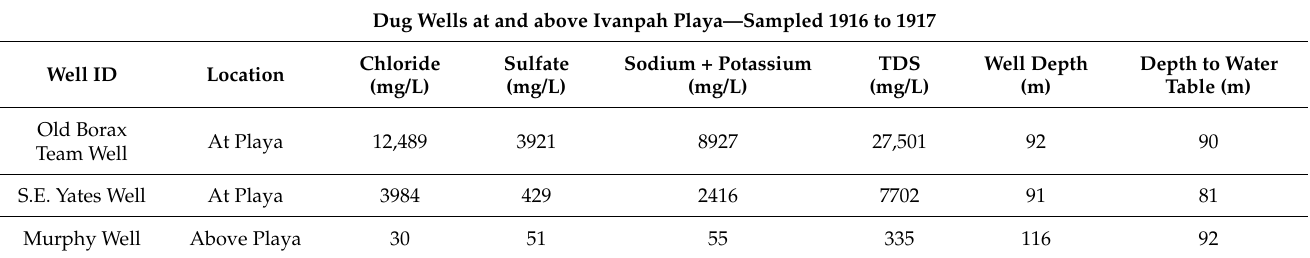
Figure 6. Site location map at Ivanpah Valley, showing water well locations and transect for soil cores on and off Ivanpah Playa (modified from [26]). Table 2. Groundwater data from dug wells at and above Ivanpah Playa (from